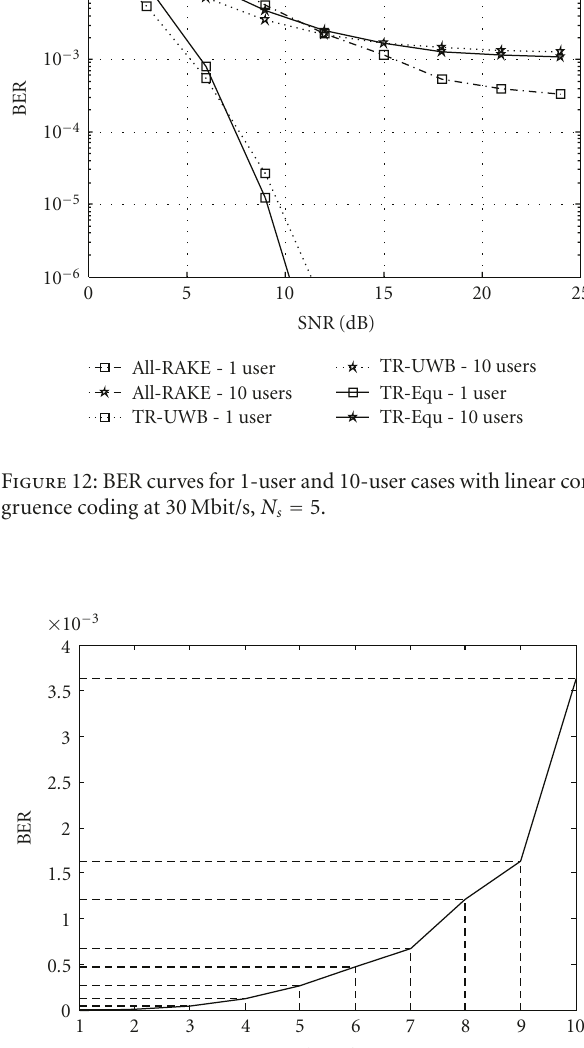
minimum error rates. Due to MUI being dominant relative to ISI in the scenarios tested, there is a closer correspondence between All-RAKE and TR-UWB error rates than in a single user system, with errors due to ISI e ff ects